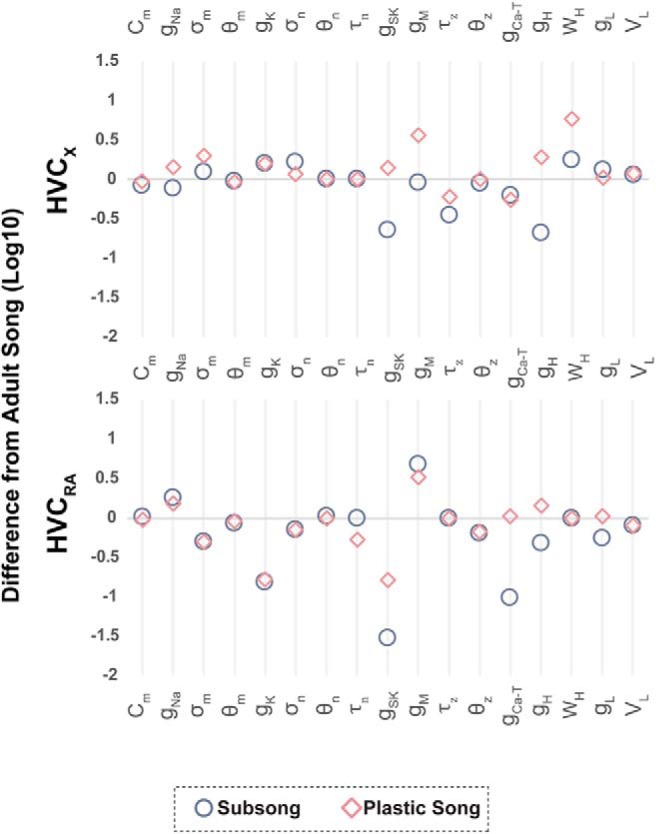
Developmental variation in ion channel parameters relative to adult. Model parameters that differed from the adult cell model are listed along the x-axis. Parameters that did not change are not displayed but can be found in Table 2. All parameter values were manually fit to representative data from Figures 3, 5. In this plot, conductance (g) values were first normalized to the capacitance of the model neuron. All values are displayed as a ratio comparing the juvenile model parameters to the adult (on a logarithmic scale). A value of zero indicates no difference relative to the adult. A value >0 indicates an increase in the magnitude of the parameter, and a value <0 indicates a decrease in the magnitude of the parameter relative to the adult. The models predict that HVCX and HVCRA neurons undergo different changes in ionic conductances as a function of development.